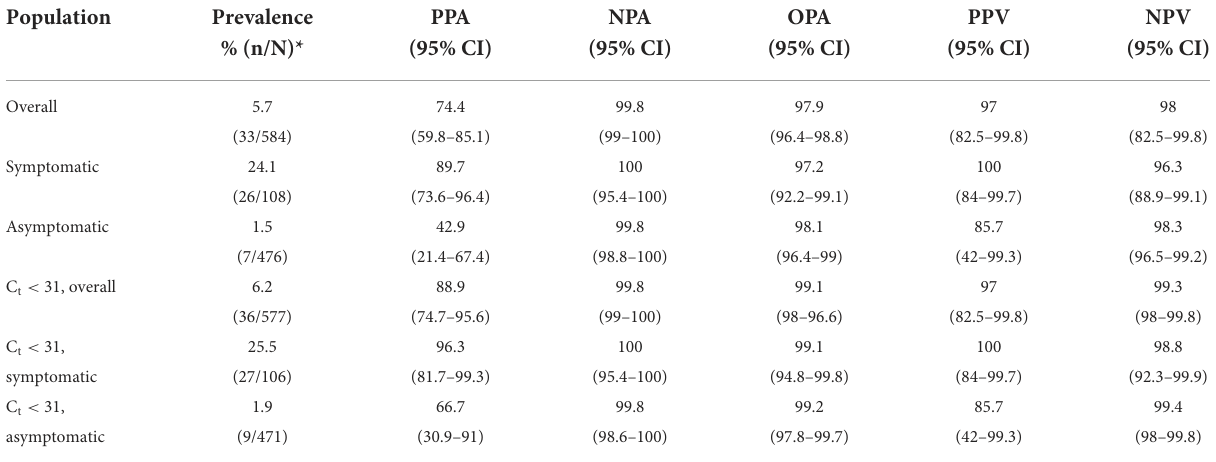
TABLE 1 Diagnostic performance of the BD Veritor System for Rapid Detection of SARS-CoV-2.